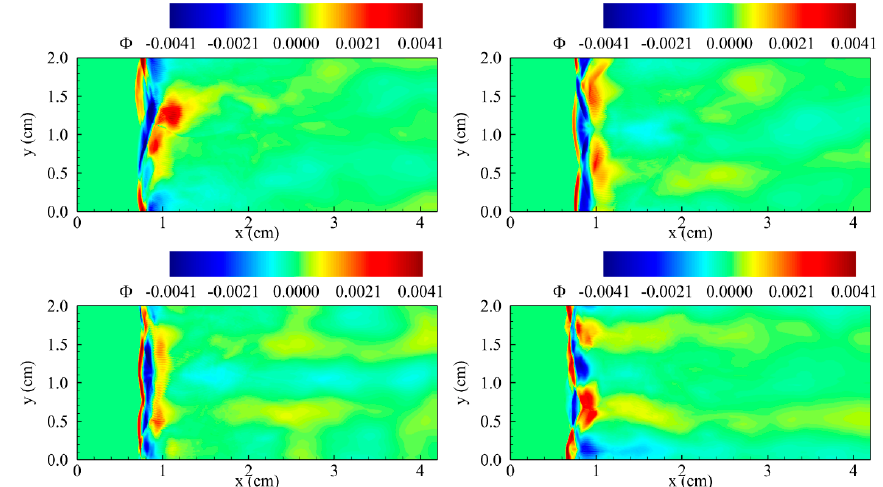
Figure 20. Secondary DMD modes of the divided region part 1—top left, part 2—top right, part 3—bottom left, part 4—bottom right.